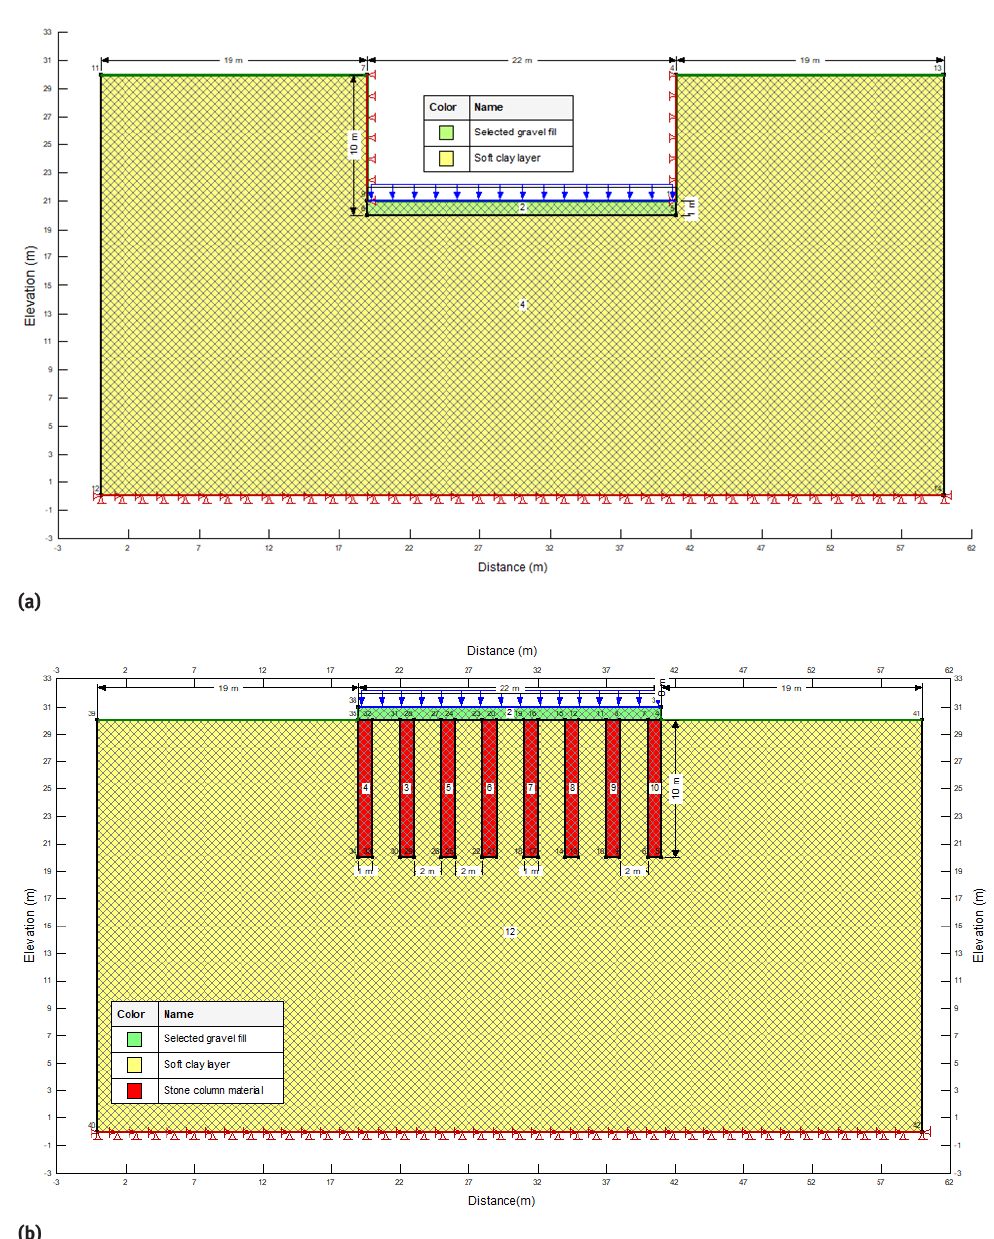
Figure 1: Geometry and boundary conditions for scenario 1 (a) and scenario 2